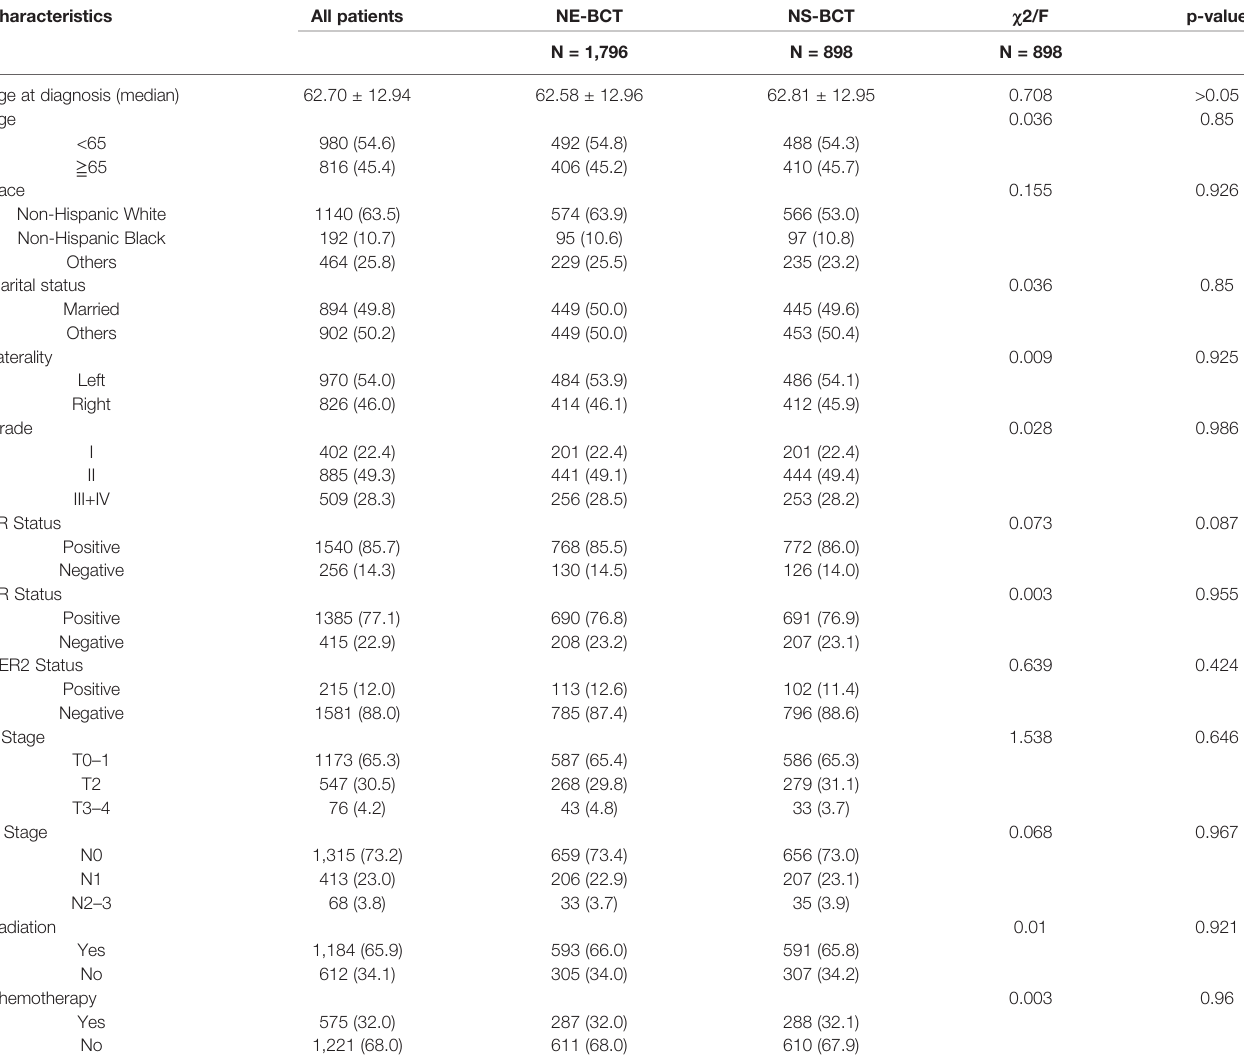
TABLE 3 | Patient clinical and pathological characteristics between 2010 and 2015.